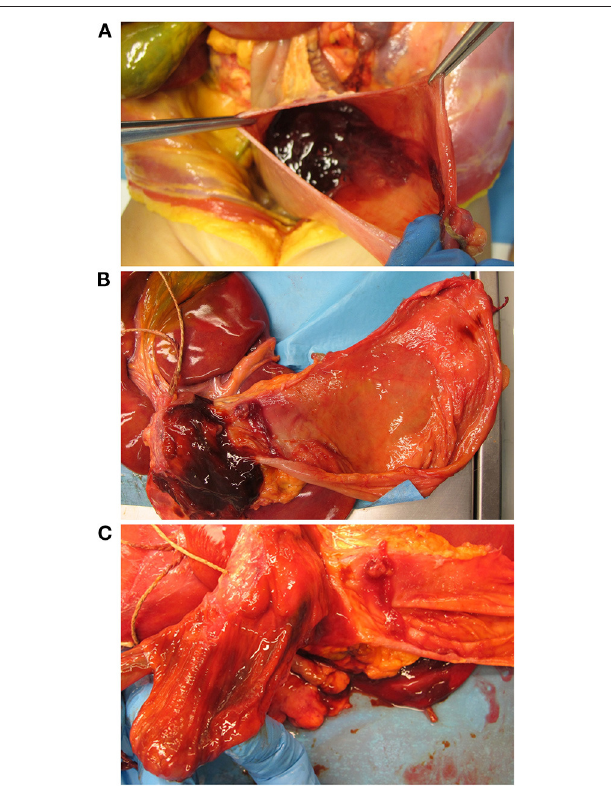
FIGURE 1 | Macroscopic examination of the gastric, pyloric, and duodenal mucosa. Opening of the stomach showing presence of a brownish gelatinous material inside, (A) which, once removed, revealed an intact mucosa without signs of lesions (B) . Presence of brownish gelatinous material in the duodenum (B) with no sign of ulcerative alteration of the pyloric and duodenal mucosa (C) .